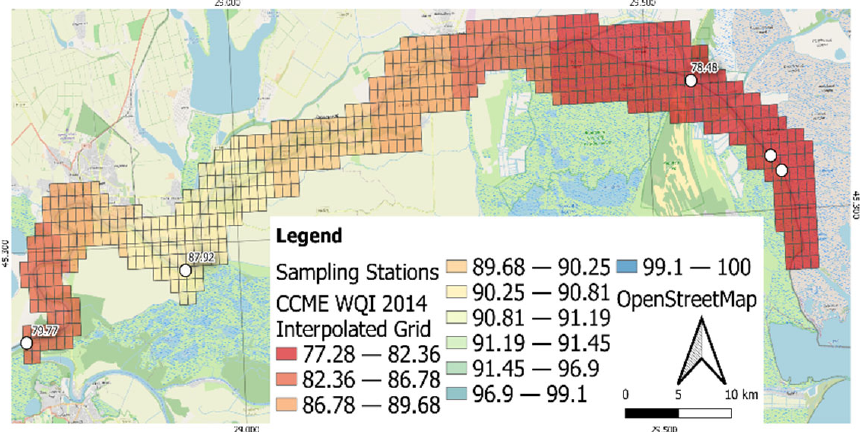
Figure 5. CCME WQI trends in 2014 on the Chilia branch.